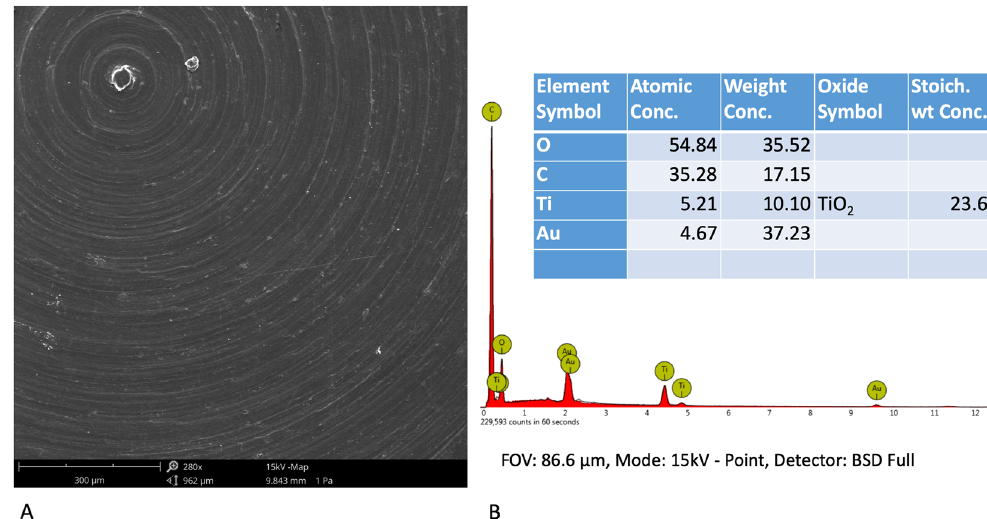
Fig. 1 Super fi cial micro-topography of PEEK samples observed at SEM ( a ) with the relative EDS spectra ( b